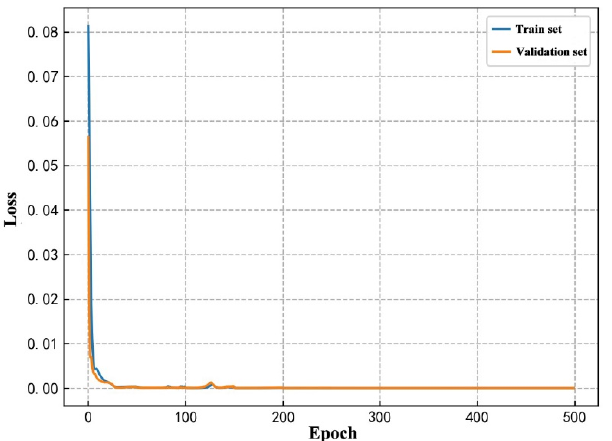
Figure 5. The atmosphere phase loss rate curve of the training set and the validation set. The loss value approaches 0 after 500 epochs.